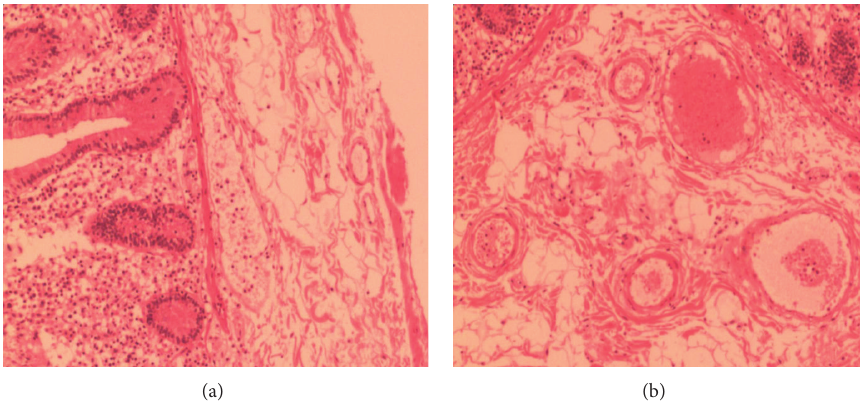
Figure 2: Muscle layer shows vacuolar degeneration, abrupt muscle fiber, and fibrosis, concluding it to be myopathy.